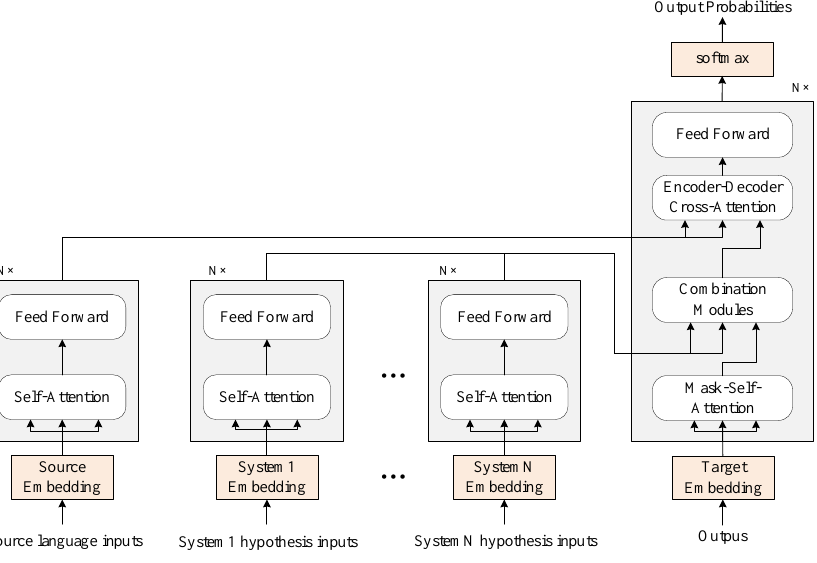
Figure 1. The architecture of the multi-source-based system combination model. The combination module is the core of the model.